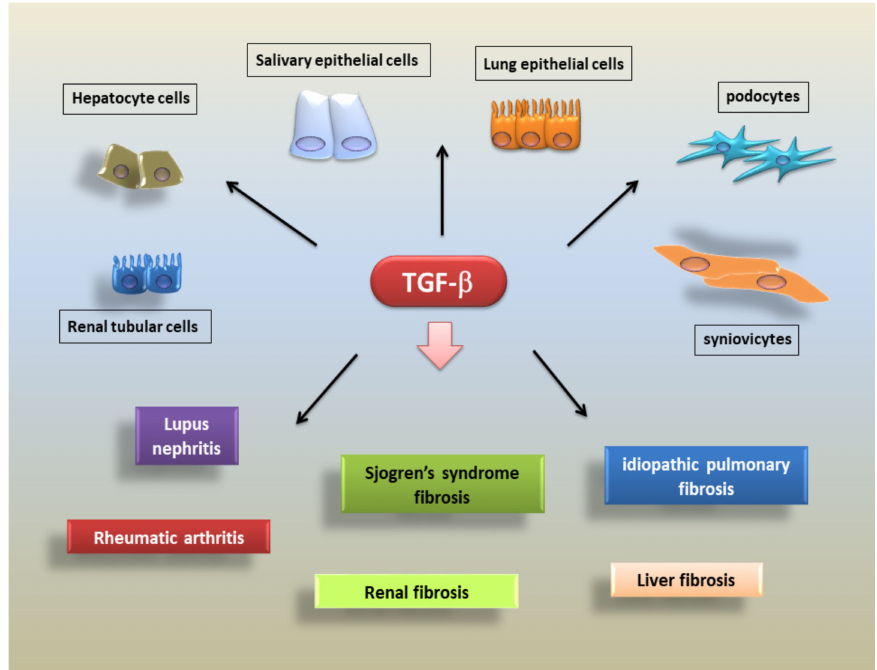
Figure 3. Schematic overview of TGF- β /SMAD and non-SMAD signalling. TGF- β triggers cellular responses by binding and activating two transmembrane Ser/Thr protein kinase receptors, denomi- nated TGF- β type I (T β R-I) and type II (T β R-II). In the canonical SMAD pathway, activation of these ligand–receptor complexes lead to the phosphorylation and activation of SMAD2/3 which, in turn, binds to cofactor SMAD4. The trimeric SMAD complex translocates into the nucleus and cooperates with other transcription molecules to regulate target gene expression. The activation of transcription factors such as Snail, Twist, or ZEB promotes the prolonged induction of EMT, repressing epithelial marker genes and activating genes linked to the mesenchymal phenotype. Feedback regulation is mediated by SMAD7 which interferes with the binding of SMAD2/3 to TGF- β receptors. In the non-SMAD pathway, TGF- β receptors activate other pathways that contribute to induce the EMT program. The RAS–RAF–MEK–ERK MAPK signalling cascade is a major non-canonical pathway activated by the TGF- β / TGF- β RI/II complex. Once activated, ERK1 and ERK2 MAPK can facilitate EMT by increasing the expression of EMT transcription